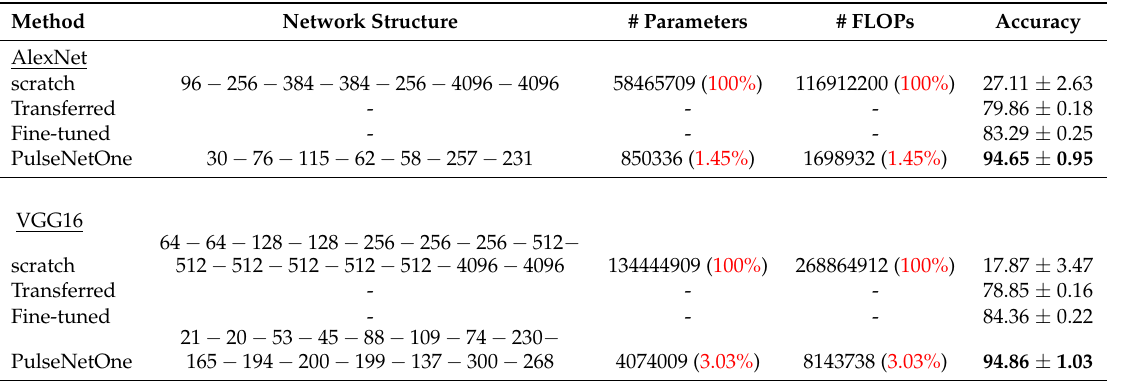
Table 6. Overall accuracies and standard deviations (%) of different CNNs methods along with PulseNetOne on the NWPU-RESISC45 dataset. The entries in bold show the method with the best classification for the network, while the percentage of the original network is highlighted in